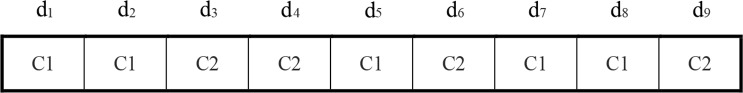
Example of the label-based representation of a candidate solution.